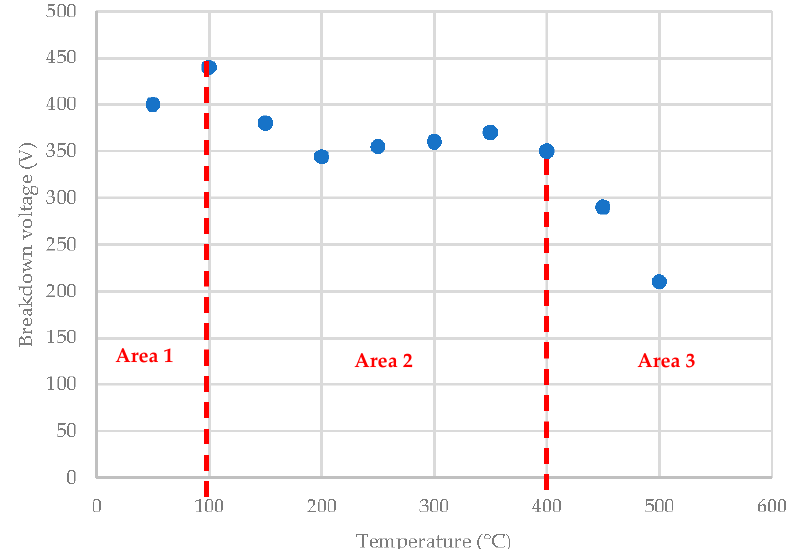
Figure 6. Temperature dependence of the breakdown voltage.